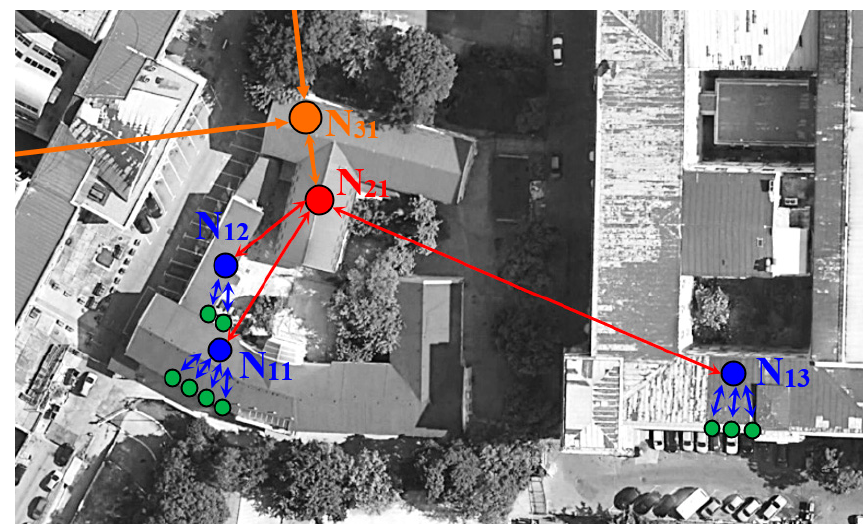
Figure 2. Deployment view of the neighboring photovoltaic systems. Table 2. The features of the used PV panels